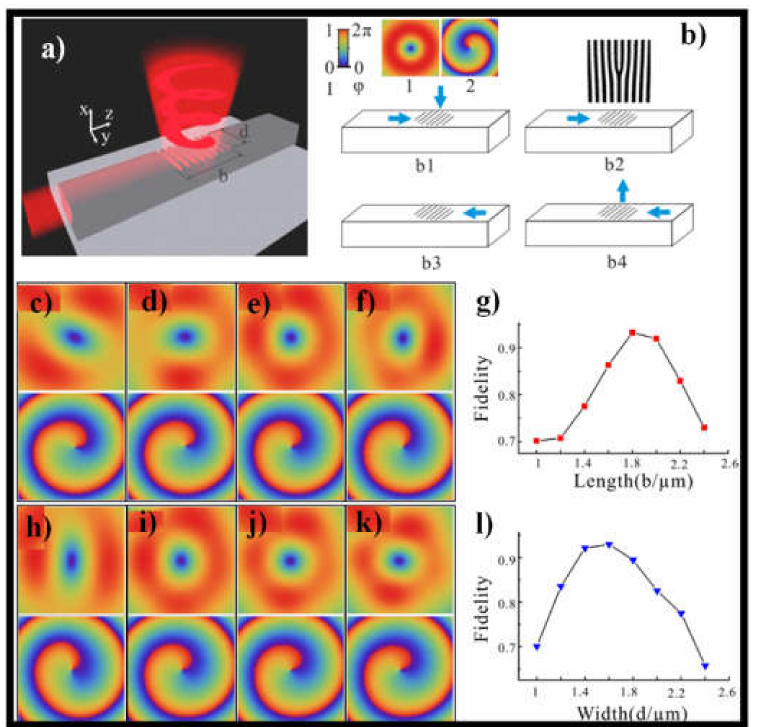
Figure 9. ( a ) The graphical image of the OV beam generator, ( b ) ( b1 – b4 ), the basis of the holographic grating on WG. The acquired OV beams by the holographic gratings with different sizes. The intensity and phase distributions are shown in the upper row and down row of the figures, ( c – f ) consistent to the holographic gratings with a constant width d = 1.5 µ m but different lengths b = 1, 1.4, 1.8, 2.2 µ m, and ( h – k ) corresponding to the holographic gratings with a constant-length b = 1.8 µ m but dissimilar widths d = 1, 1.4, 1.8, and 2.2 µ m, respectively, ( g , l ) are the fidelities of the attained OV beams as the functions of length b and width d , correspondingly. Reprinted with permission from ref.